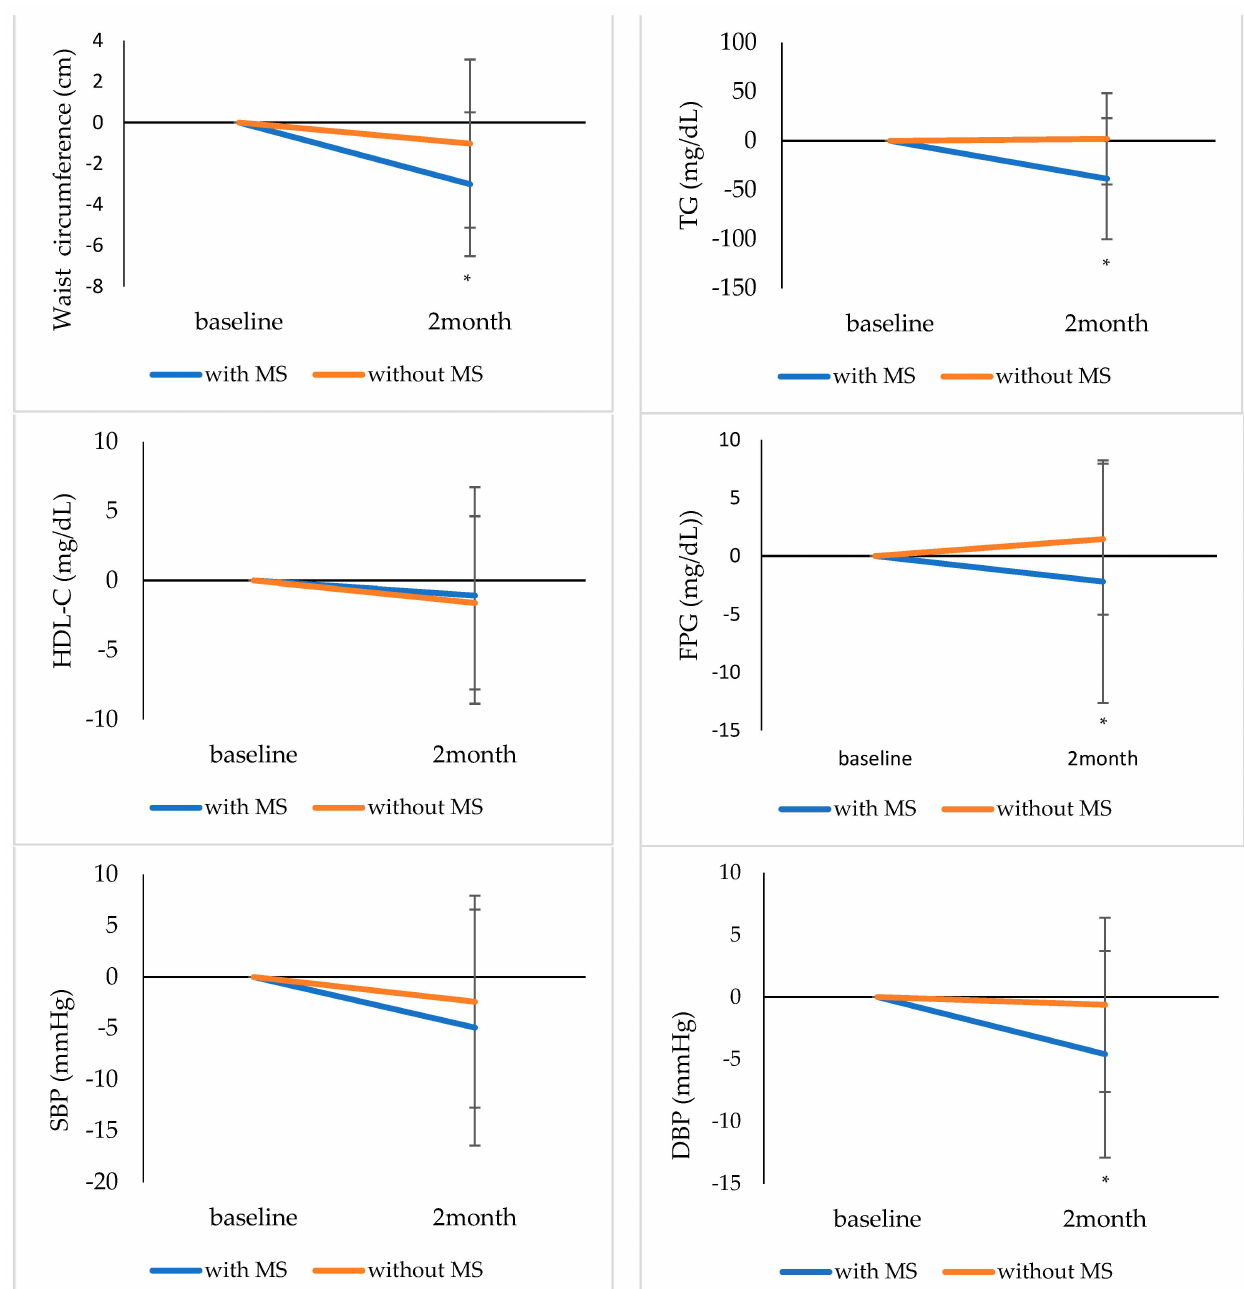
Figure 3. Mean profile plots of the components of MS by the presence of MS. The symbol * indicates that the group × time p -value < 0.05. MS, metabolic syndrome; TG, triglycerides; HDL-C, high- density lipoprotein cholesterol; FPG, fasting plasma glucose; SBP, systolic blood pressure; DBP, diastolic blood